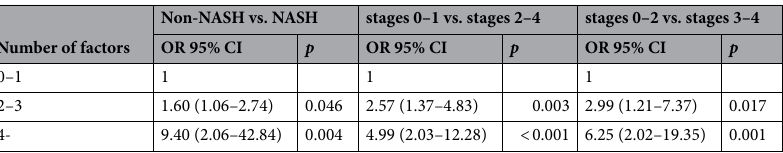
Non-NASH vs. NASH stages 0–1 vs. stages 2–4 stages 0–2 vs. stages 3–4 Number of factors